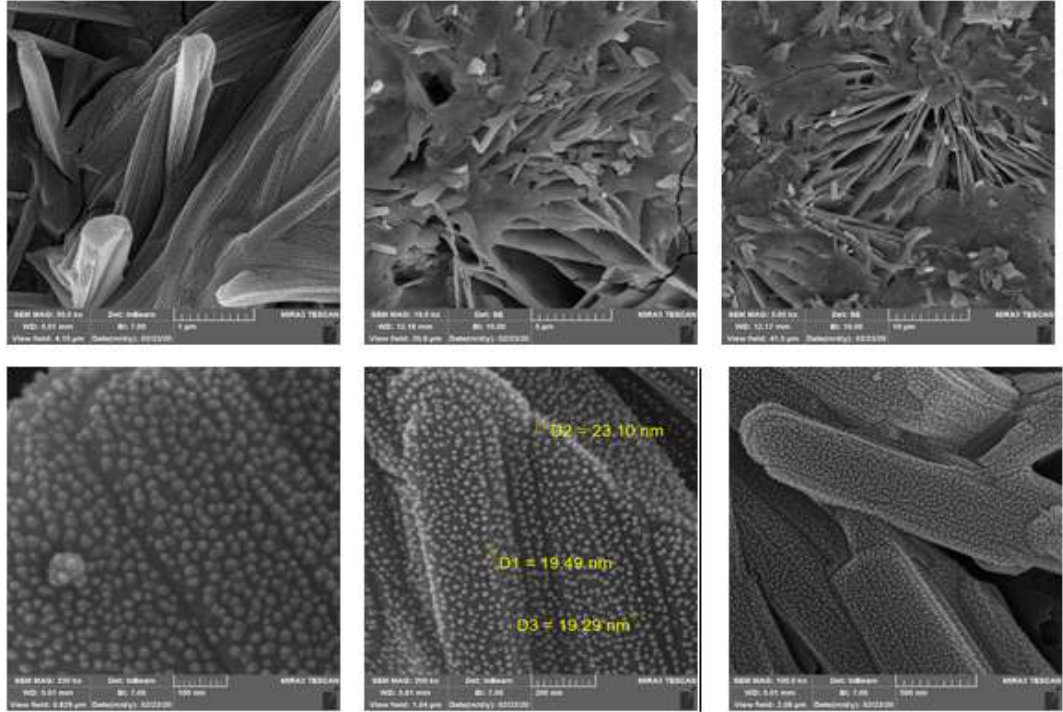
Fig.7: The SEM micrograph for CNTs-Sr(OH)